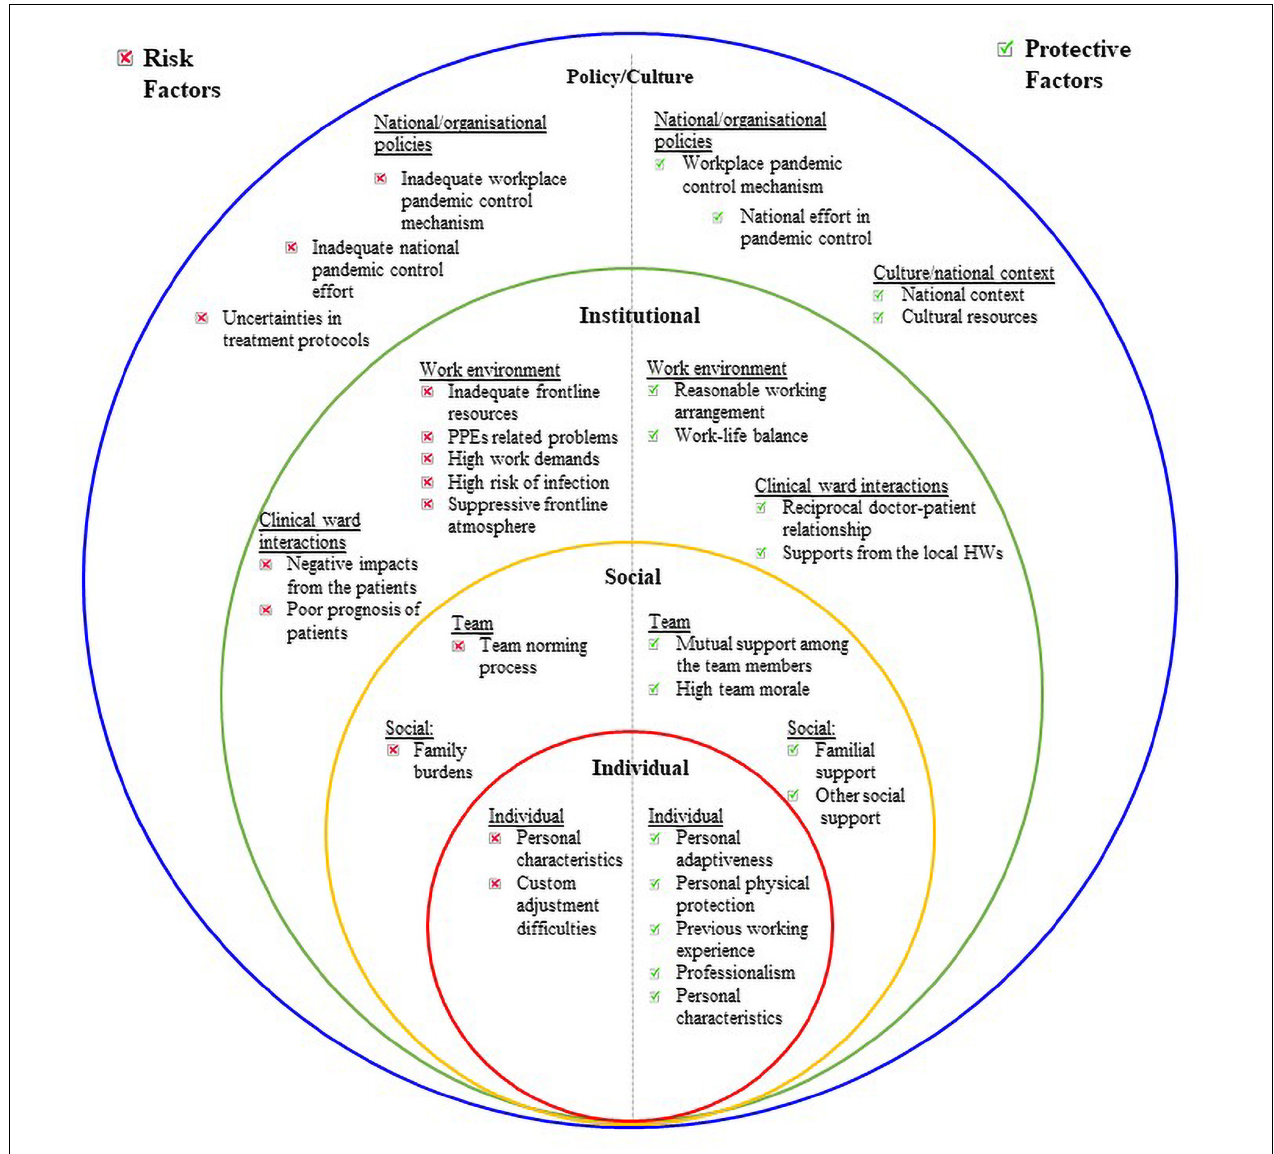
FIGURE 2 | Social-ecological model to illustrate the protective and risk factors for the wellbeing of the interviewees.